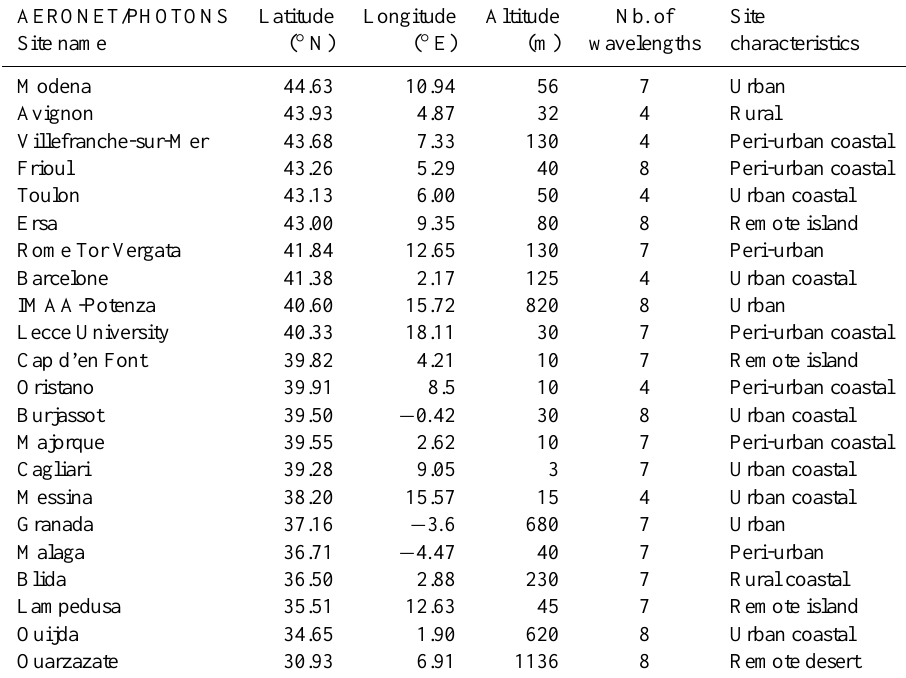
Table 2. List of the long-term AERONET/PHOTONS sun-photometer stations operated in the western Mediterranean during the ChArMEx/ADRIMED (SOP-1a)